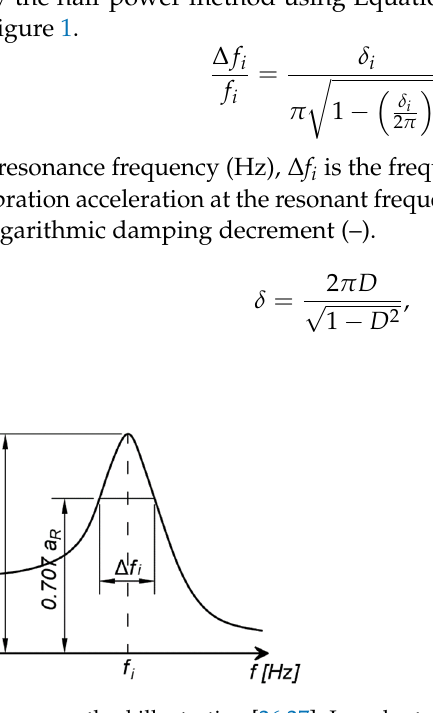
Figure 1. Half-power method illustration [26,27]. In order to obtain the critical damping ratio (D) an appropriate algebraic operation should be applied to the measured value of the logarithmic damping decrement (see Equation (3)) acc. [28].